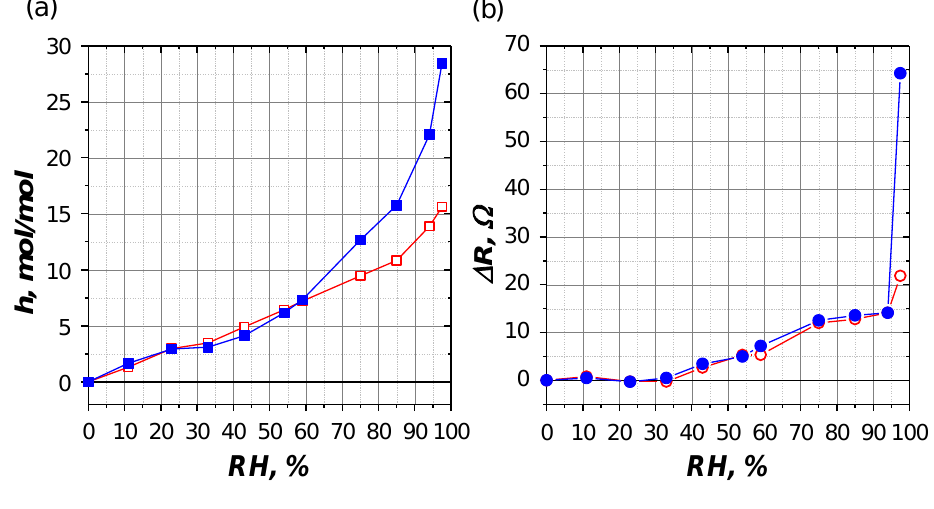
O per mole of nucleotide, of AMP (empty Figure 5. ( a ) Sorption isotherms in moles H 2 squares) and ATP (filled squares) solid films; And ( b ) Equivalent loss resistance in AMP (empty circles) and ATP (filled circles) solid